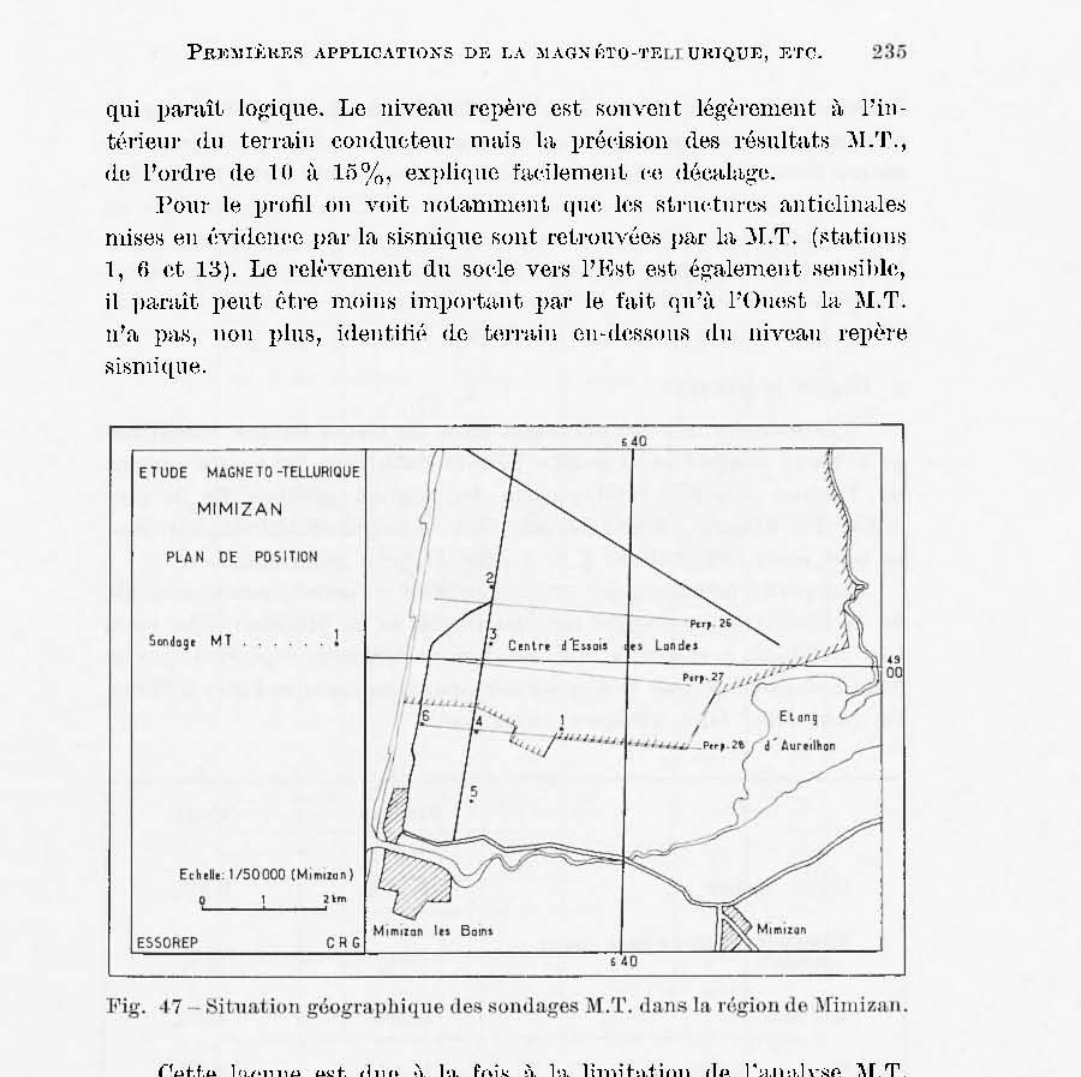
Fig . .j i - Sitllatioll googr<lphi(juc dcs sontlllges ~r.'l'. tlalls la l'égioll de ~!iIJJi7.all. Cet,te la.(,une est, (ll!l~ ù. h Ioii! à h lilllih~tion (le l'a.wllyf!c